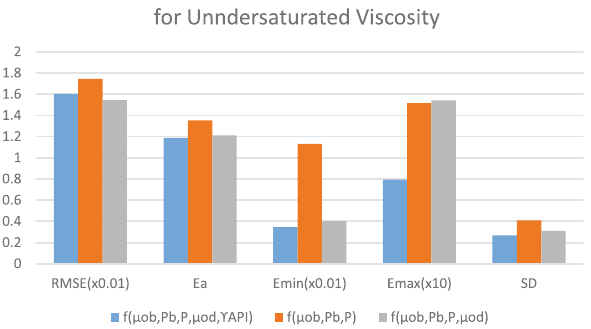
Fig. 3 Results of different functional forms for l oa prediction with in Table 9. The functional form f ( l the best result with RMSE = 0.016043, E